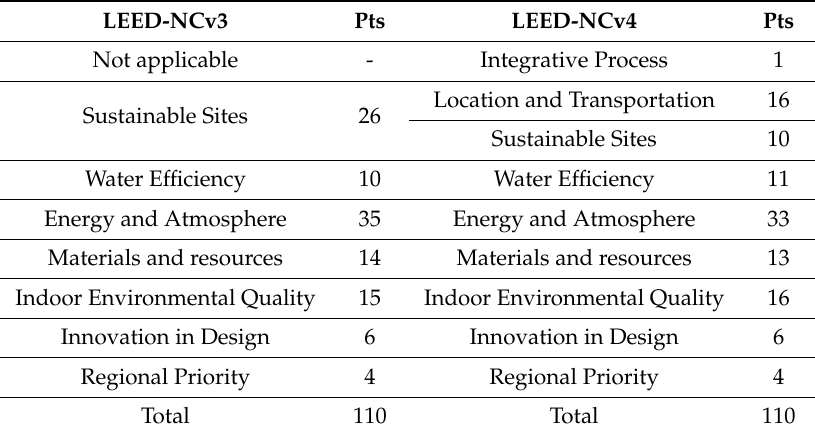
Table 1. LEED-NCv3 vs LEED-NCv4: categories with allocated points. LEED-NCv3 Pts